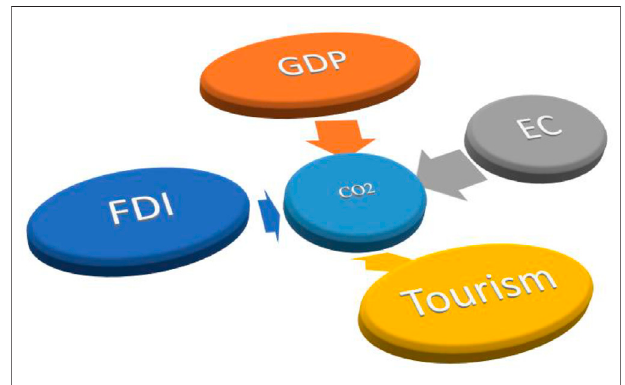
FIGURE 1 | Conceptual framework of the